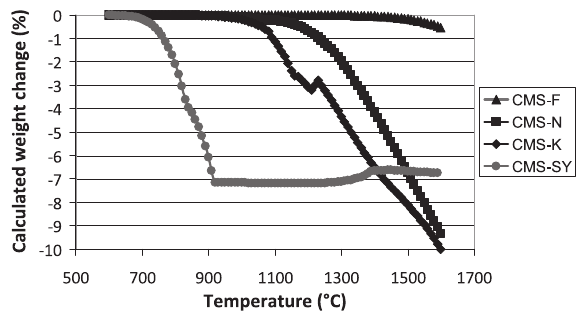
Fig. 4: Simulated mass loss from the FactSage thermodynamic software Slag Composition and